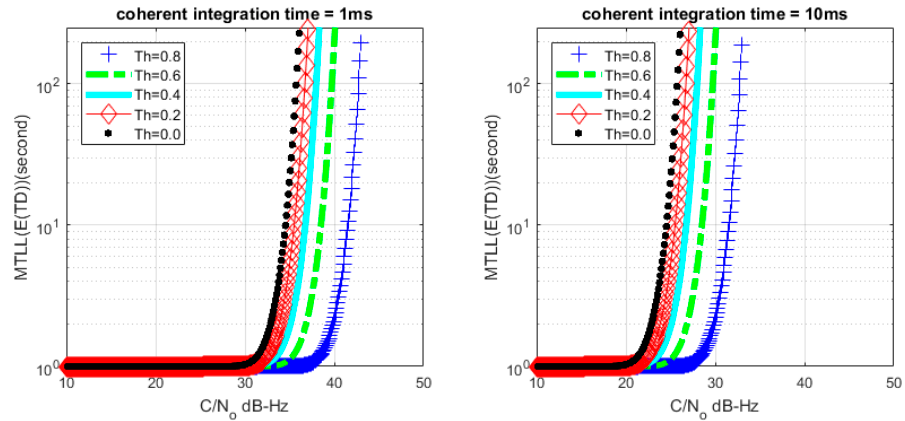
E T ) and C / N 0 ( M = 20) under signal presented situation. D